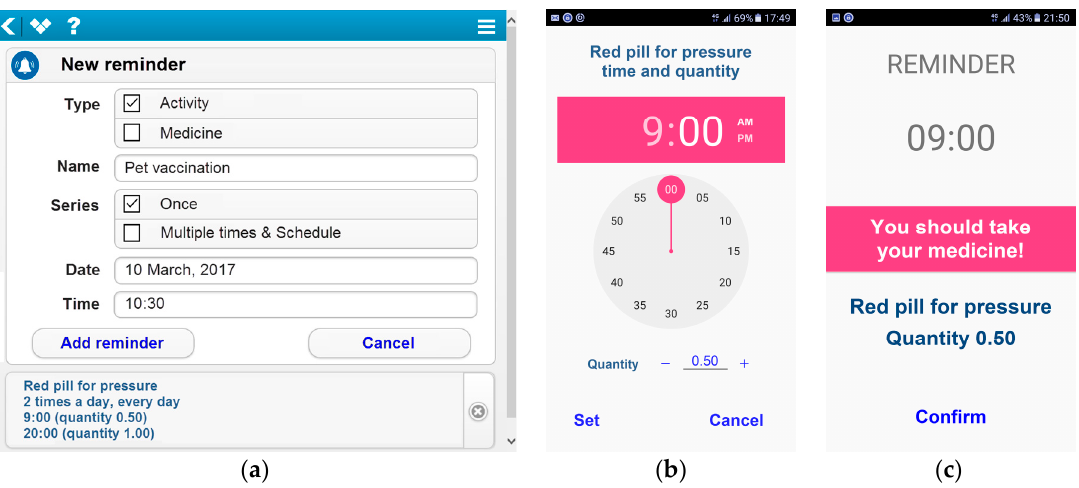
Figure 7. Reminder service screens of Senior App Suite ( a ) new activity reminder definition ( b ) setting time and quantity for a medicine schedule and ( c ) receiving a reminder alert.